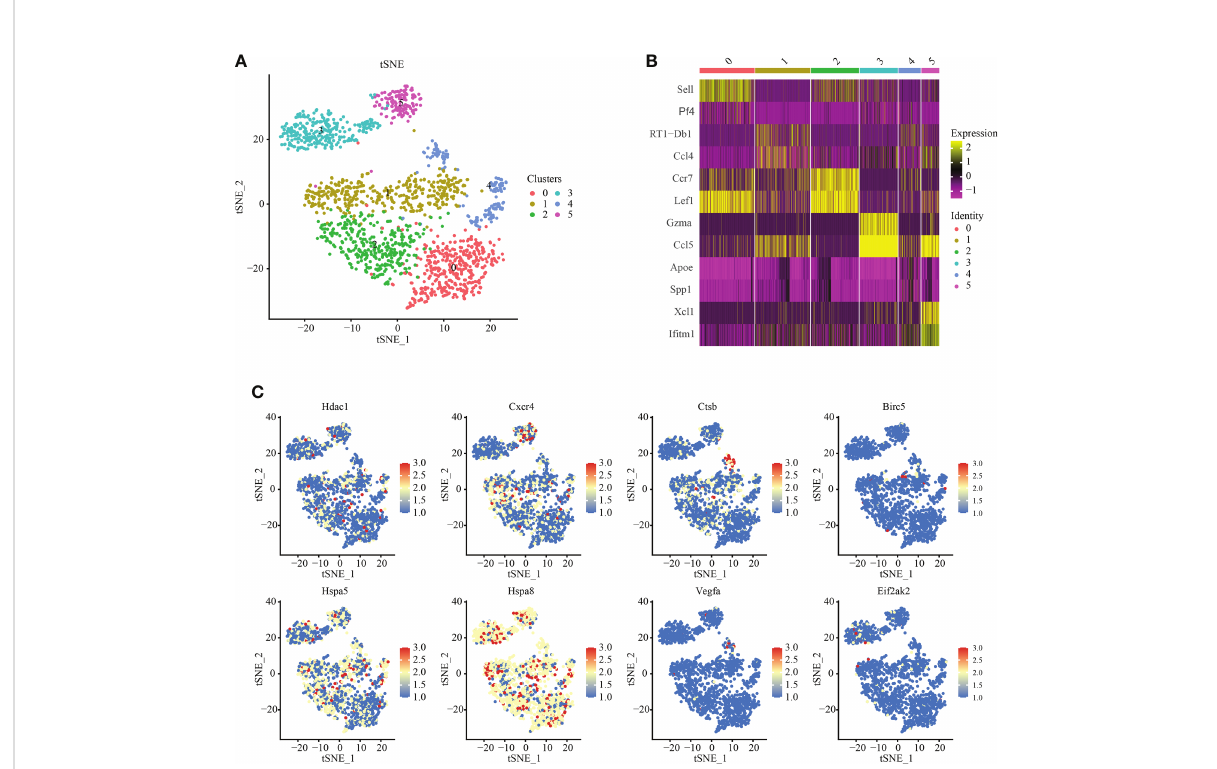
FIGURE 4 T-cell subset analysis and pseudosequential analysis. (A) t-distributed stochastic neighbor embedding (t-SNE) distribution of different cell clusters. (B) Heat map showing the differential genes among each cluster, displaying the two most highly expressed genes of each cluster. (C) Feature plot showing the expression pattern of IRAFs in T cell